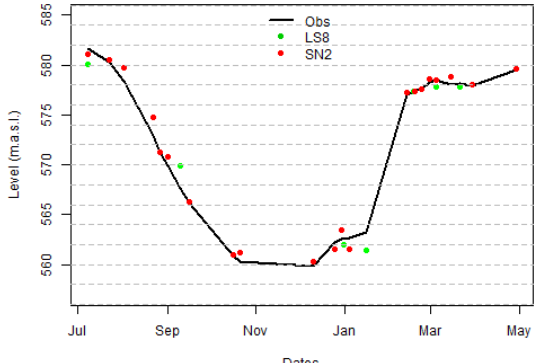
Figure 3. Water levels in the Itoiz reservoir between 1 July 2018 and 1 May 2019. The water levels are in meters above sea level (m.a.s.l.). The black line represents the observations (Obs). Green and red dots are estimates from Landsat-8 (LS8) and Sentinel-2 (SN2), respectively. The dashed line (Est) shows the combination of Landsat-8 and Sentinel-2 water